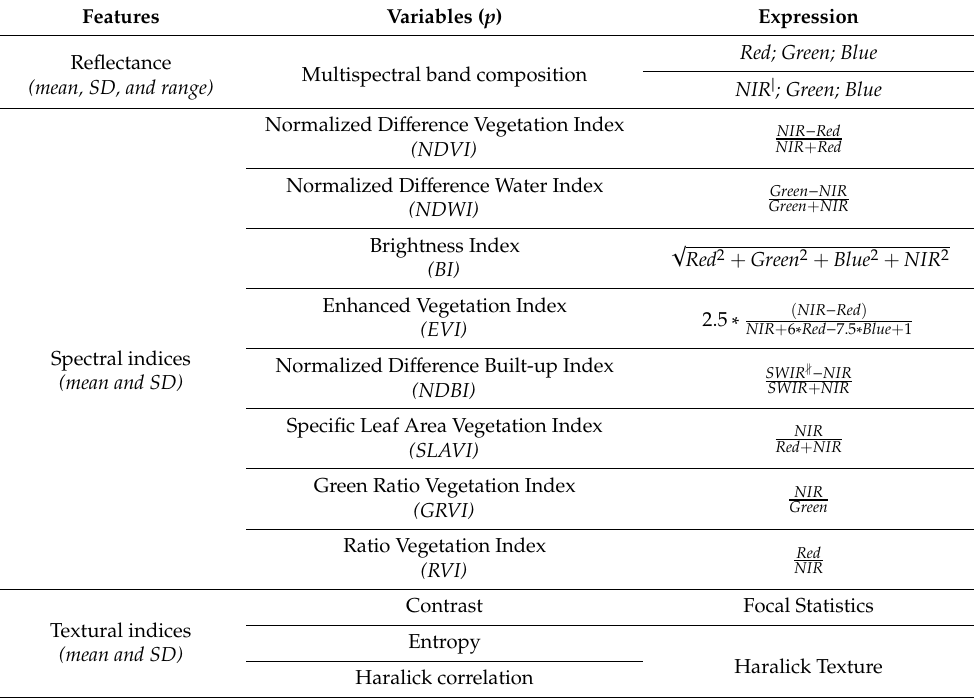
Table 2. Feature extraction from Landsat Analysis Ready Data (ARD) imagery based on reflectance, spectral and textural